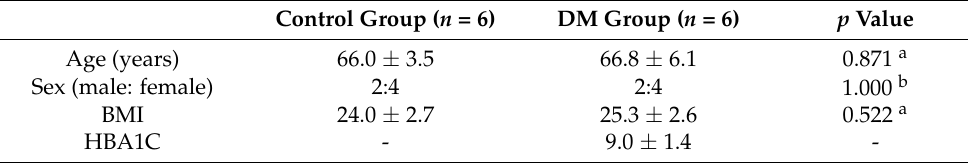
Table 1. Demographics and Baseline Clinical Characteristics of the Study Participants.